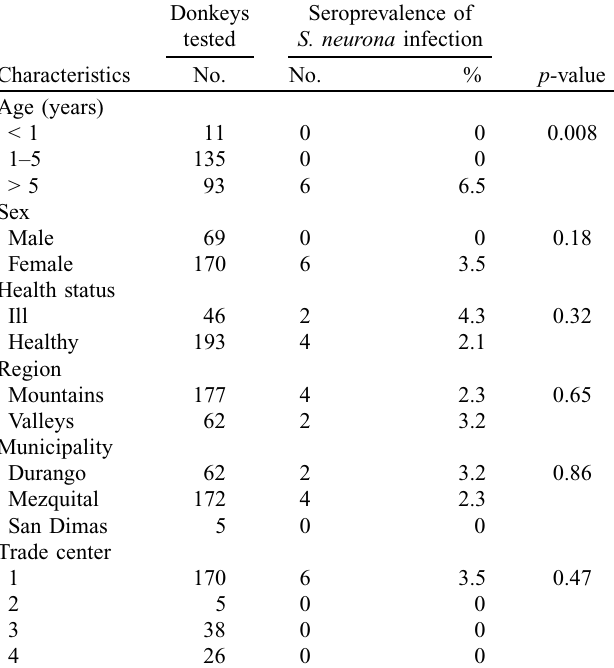
Table 1. General data for the 239 donkeys studied and seropreva- lence of Sarcocystis neurona infection. Donkeys Seroprevalence of tested S. neurona